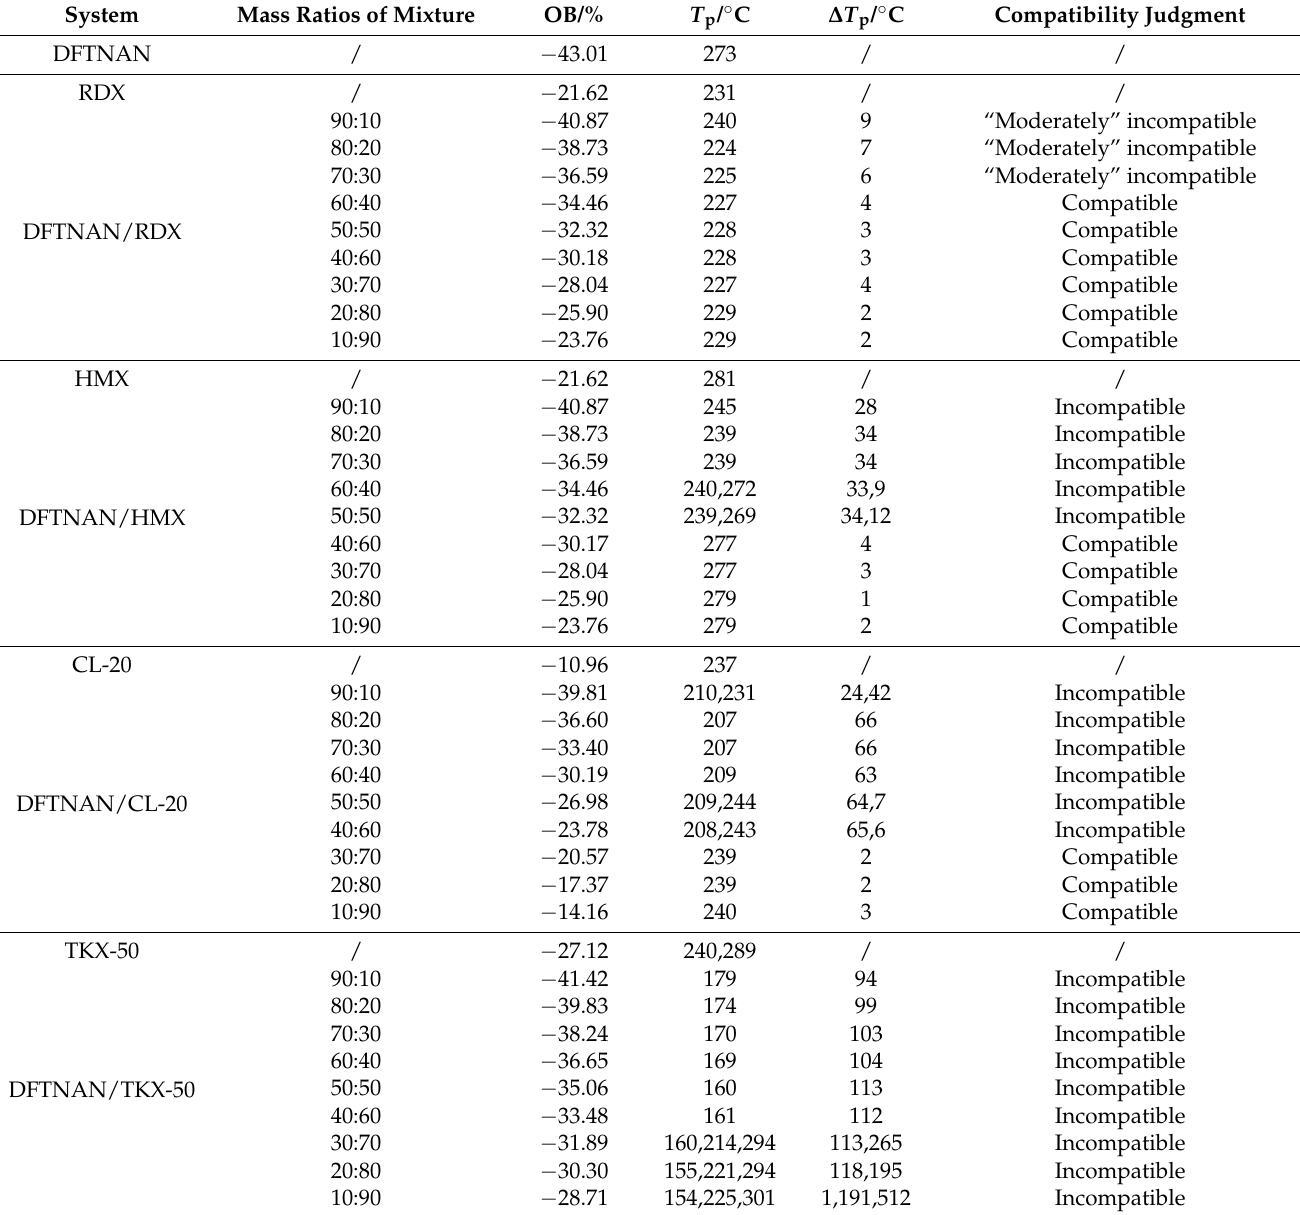
Table 5. Compatibility results of DFTNAN-based mixture explosives by